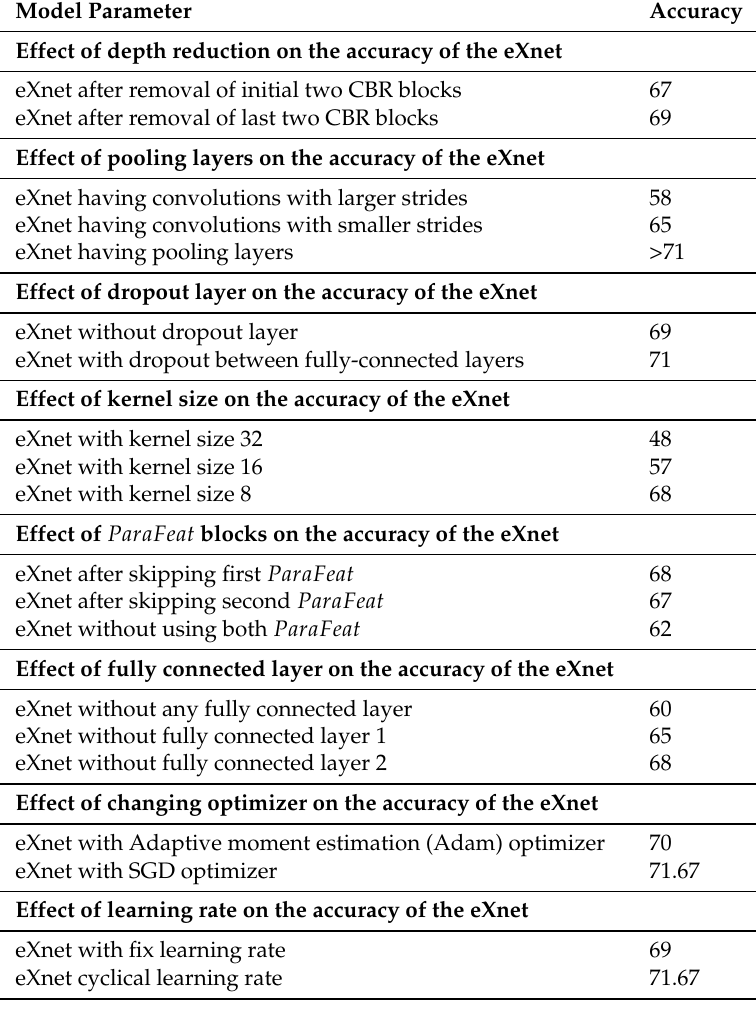
Table 2. Ablation evaluation of